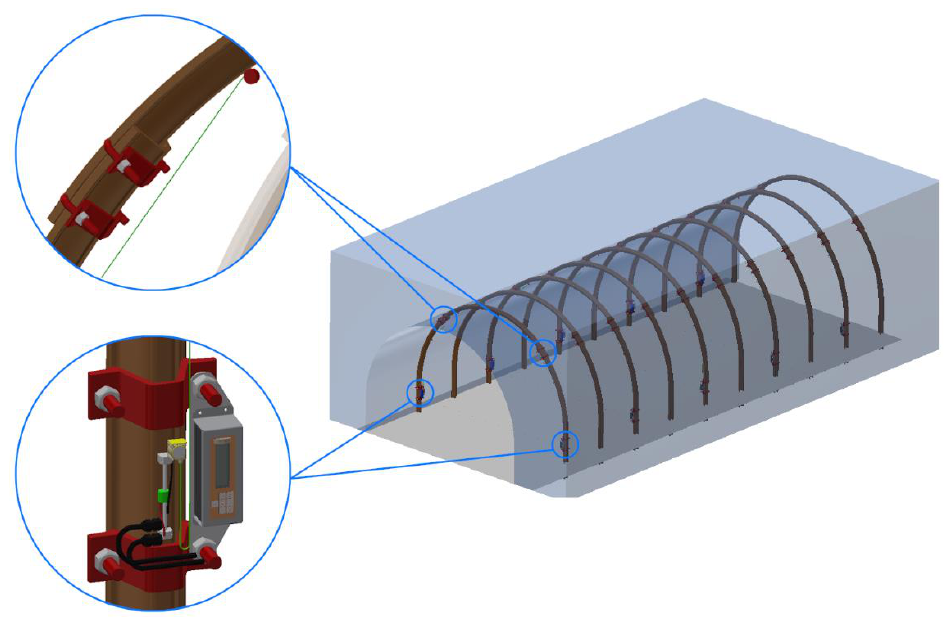
Figure 2. Concept of installation measuring modules.